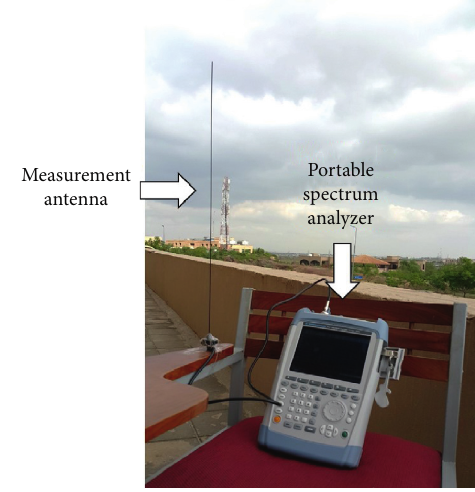
Figure 4: Measurement